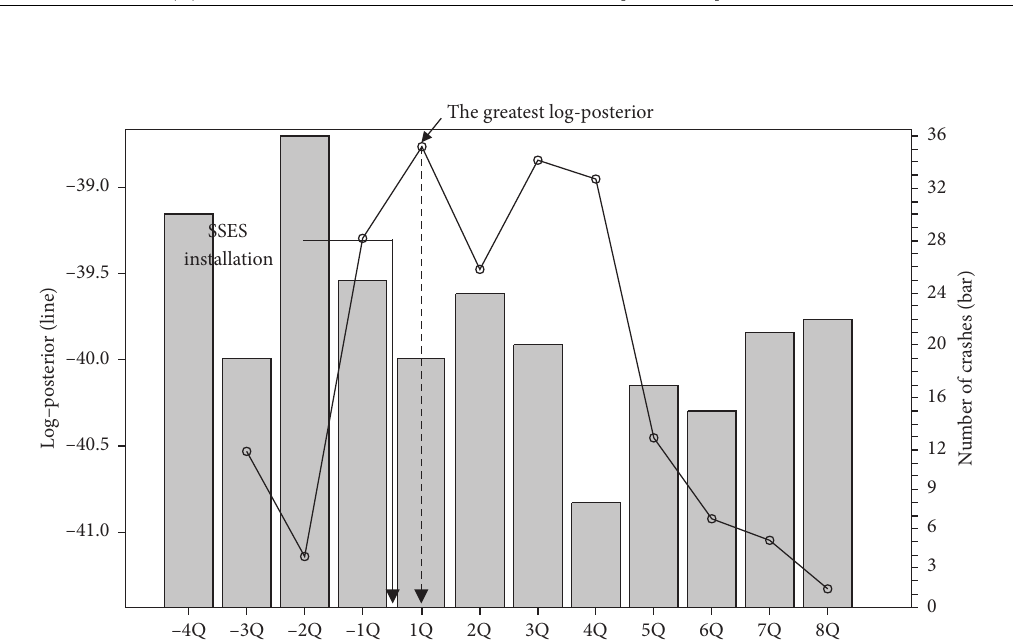
Figure 5: Comparison between time of SSES installation and greatest log-posterior